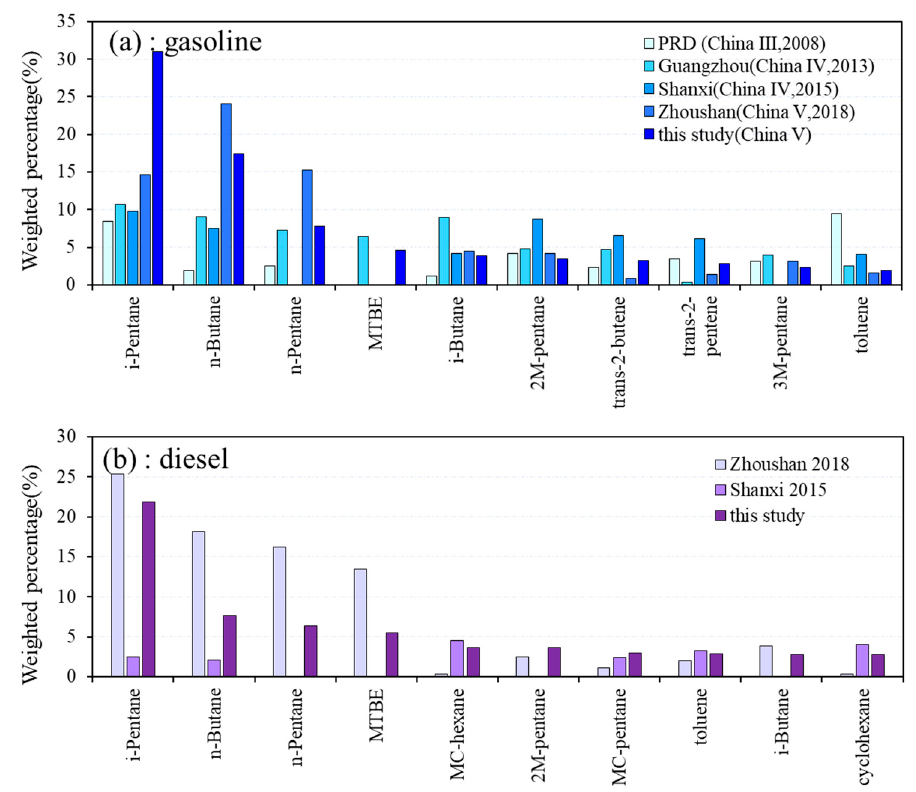
Figure 12. Top 10 VOCs species in gasoline and diesel vapor and their contributions in other studies in different regions and studying periods, ( a ) gasoline; ( b ) diesel .